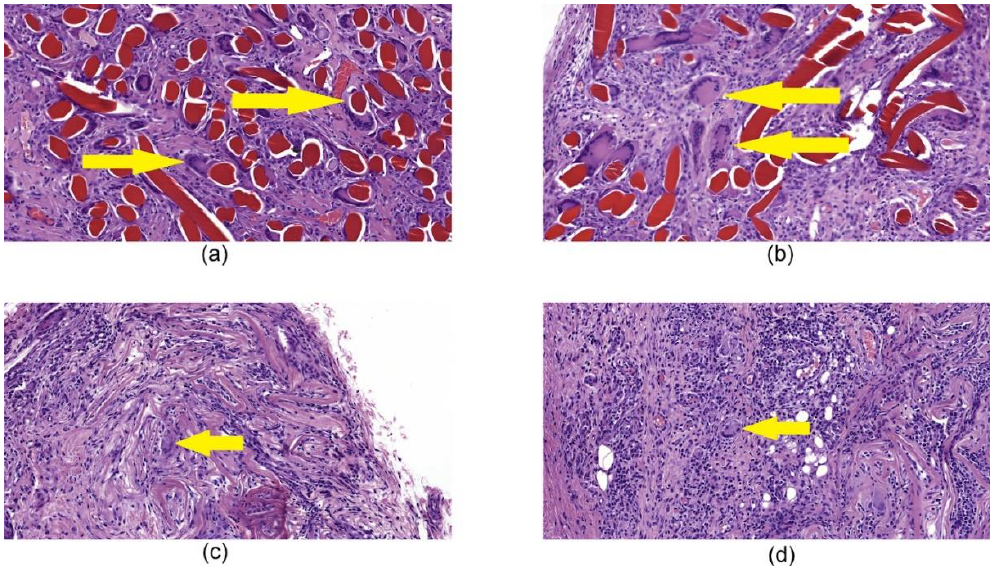
Figure 9. Histological microphotographs of biopsy samples of tissues with implanted hemostatic materials taken on the 14th day after beginning of the experiment, magnification 200×. ( a ) chitosan non-woven material, the arrow points to giant cells in granuloma; ( b ) [chitosan + 0.5% ChNF] non-woven material, the arrow points to giant cells in granuloma; ( c ) “Surgicel” hemostatic material, the arrow points to giant cells; ( d ) “TachoComb” hemostatic material, the arrow points to giant cells between infiltration.